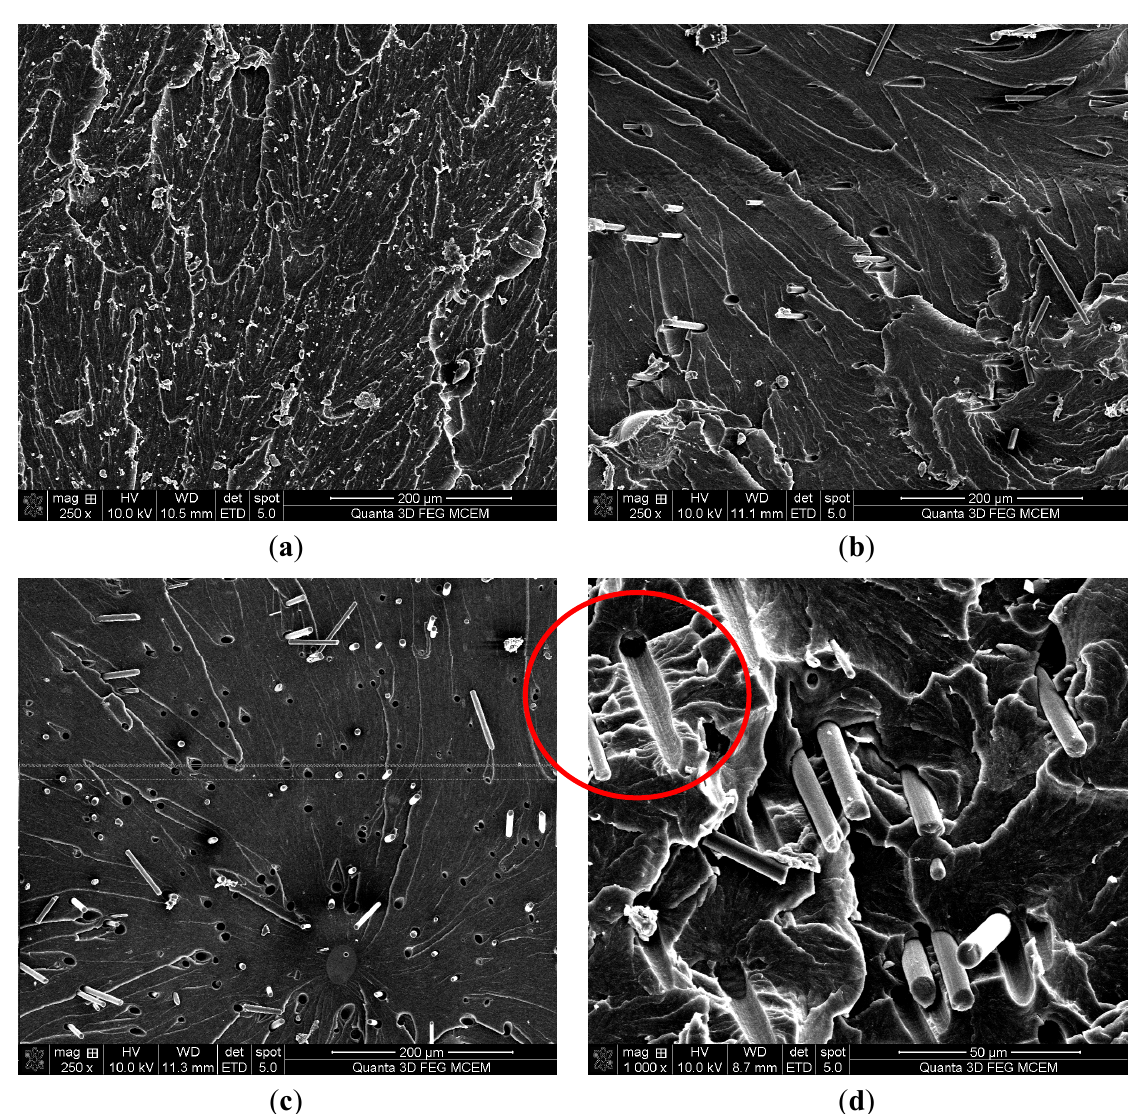
Figure 8. Typical scanning electron microscopy (SEM) images of epoxy specimens